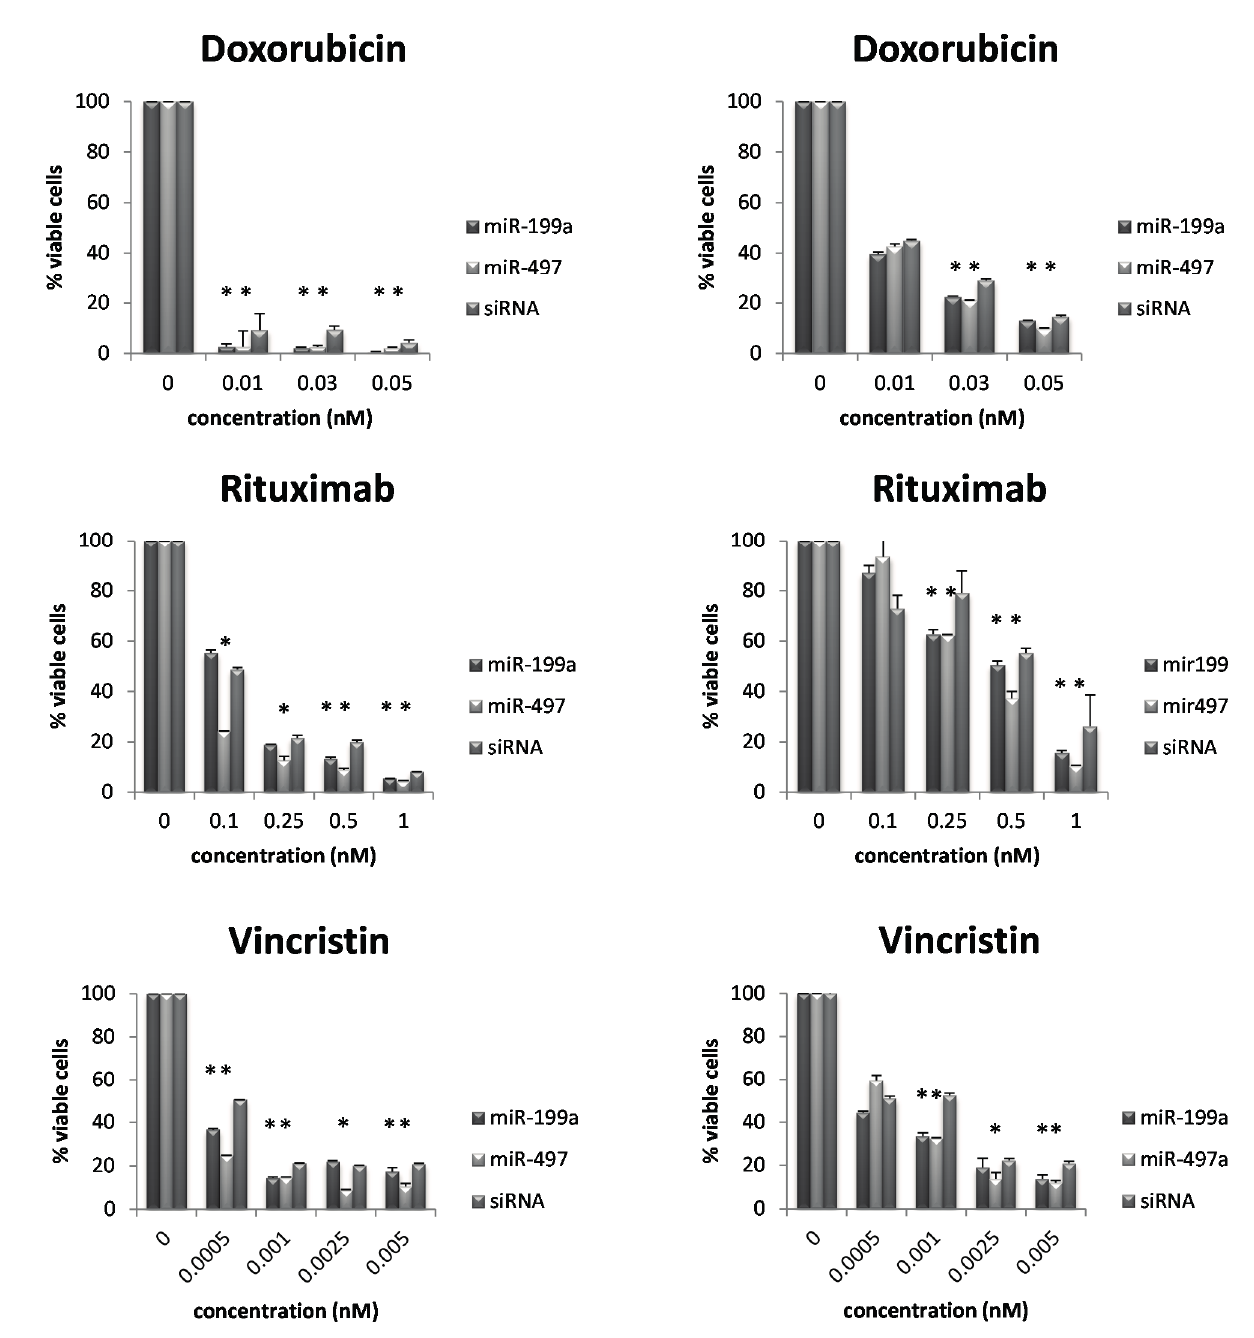
Figure 4. Validation test with Annexin V/7-aminoactinomycin D (7-AAD). Cell viability of RI-1 ( left column ) and SUDHL4 ( right column ) cells treated with doxorubicin, rituximab, and vincristin. Each bar represents the mean cell viability ± standard deviation of either miR-199a or miR-497 transfected cells or siRNA control, respectively. Plotted against the x -axis are the used concentrations in nM. Percentage of double negative cells was taken to determine viability. * indicates reduced cell viability compared to siRNA ( p <